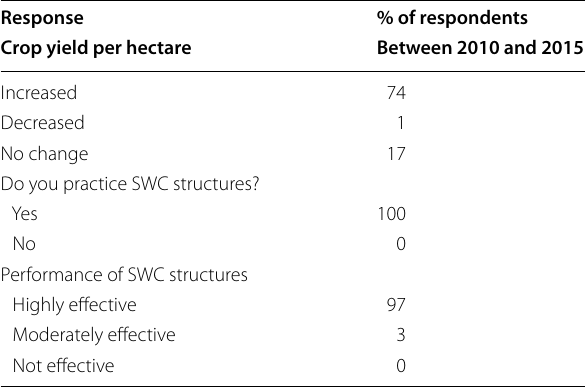
Table 8 Farmers’ perceptions for crop yield and soil and water conservation structures in the study area in